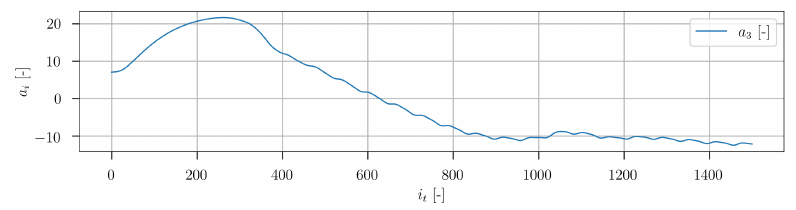
Figure 8. Temporal coefficient of POD mode 3 over the snapshot index.